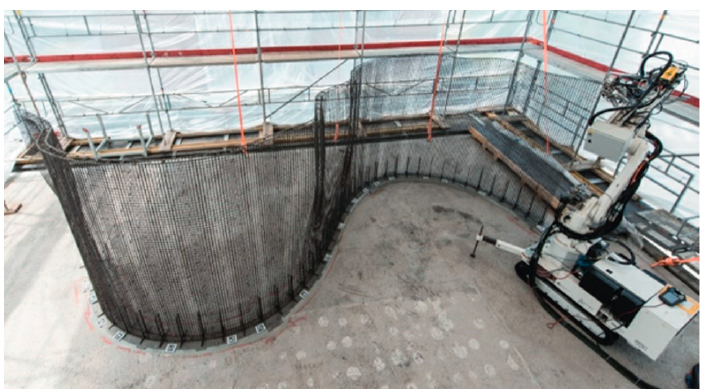
Figure 4. Production of 14 m long mesh for a double curved load-bearing wall for the DFAB HOUSE, Switzerland. Reprinted with permission from ref. [49]. Copyright 2018 Cement and Concrete Research.